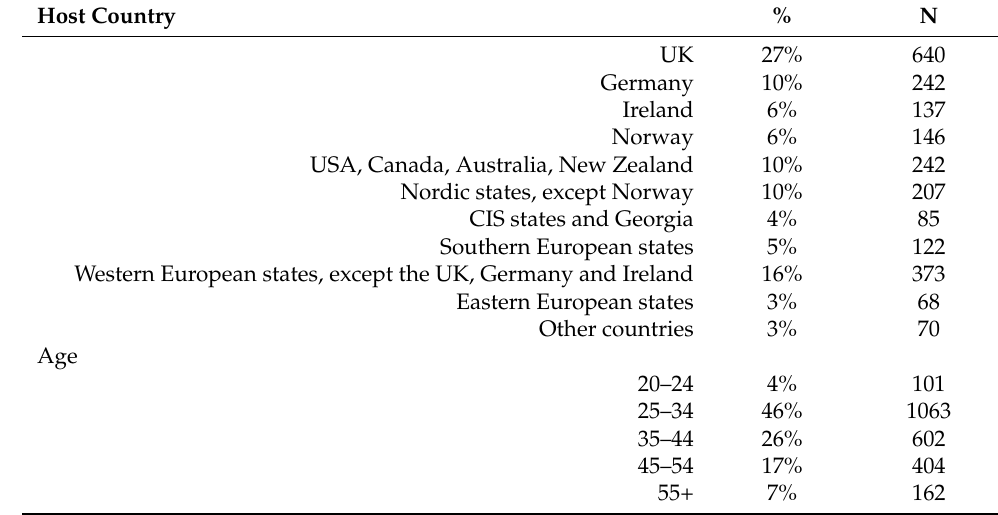
Table 1. Respondents (women with a tertiary education) according to host country, age, education, family status and time of emigration (N =